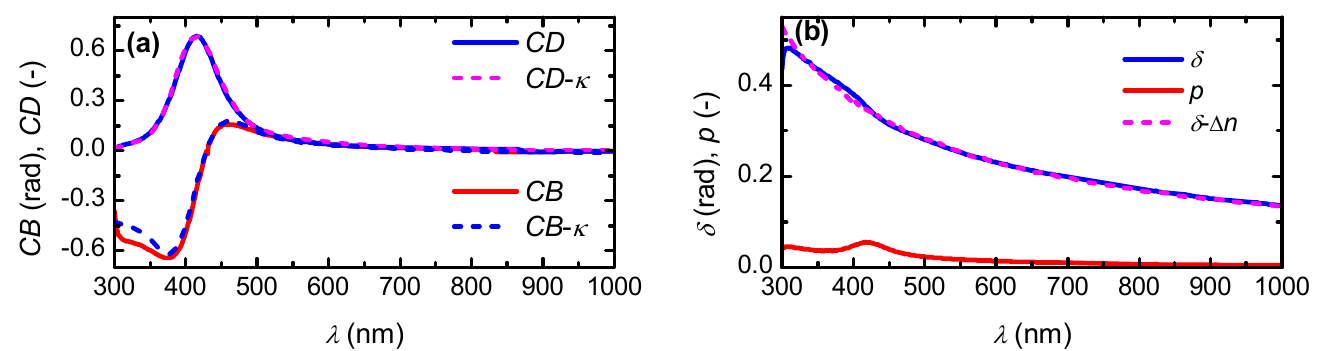
Figure 6. Elementary polarization properties determined from the analytical inversion of experimental Mueller matrix data in Figure 4. ( a ) Circular dichroism ( CD ) and circular birefringence ( CB ). ( b ) Linear retardance ( δ ) and linear diattenuation ( p ). The dashed curves correspond to properties determined using the Tellegen constitutive equations.